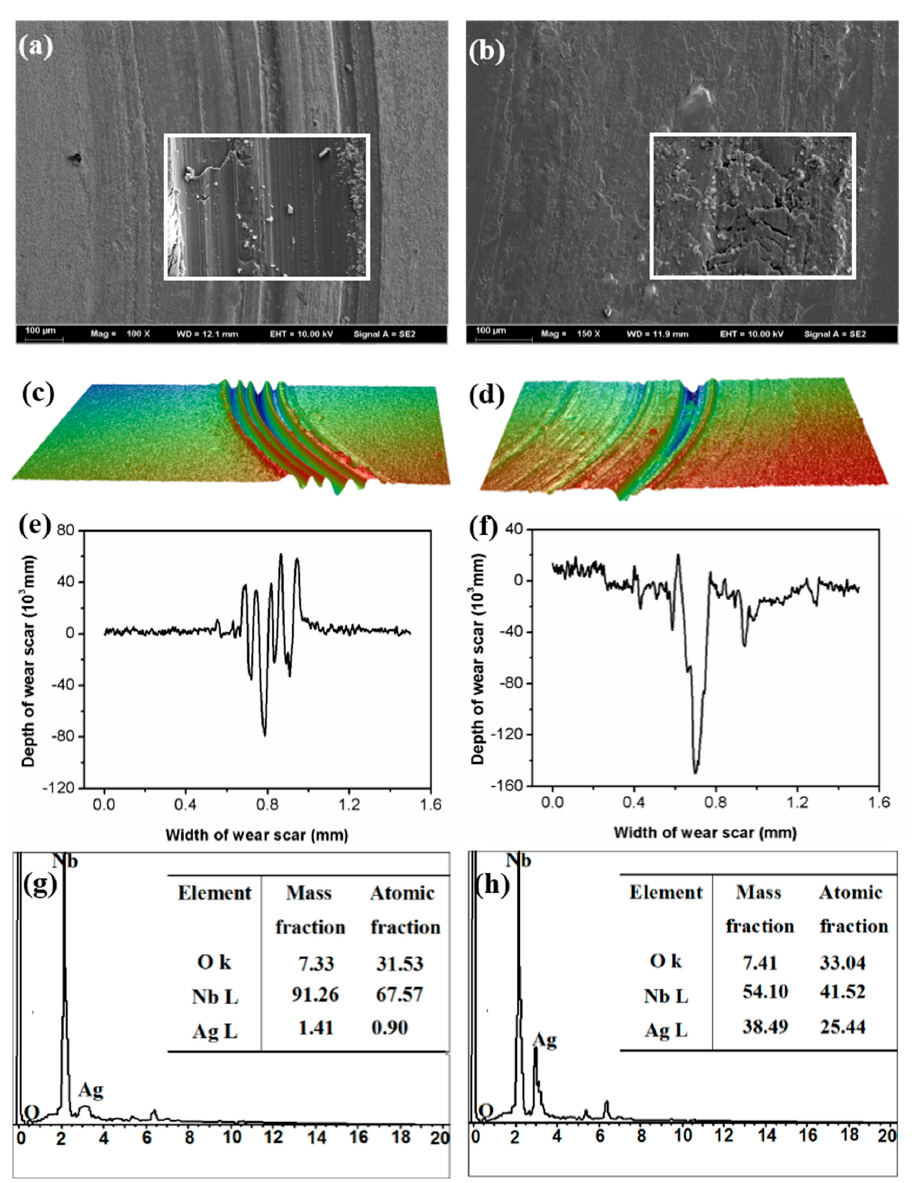
Figure 14. SEM ( a , b ) and three-dimension profiles of the worn surface ( c , d ), the corresponding